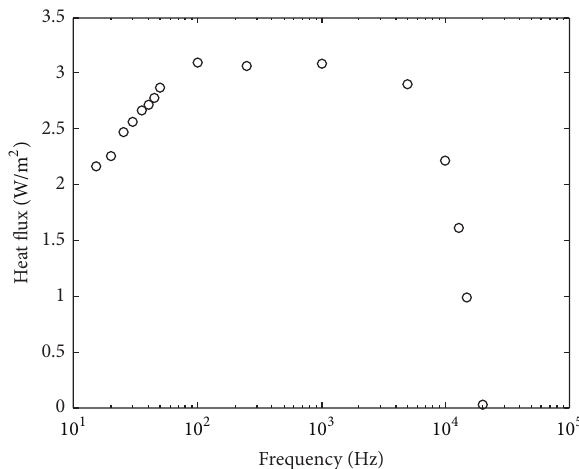
Figure1:Variationofsteadystateheatfluxatdifferentfrequenciesof excitation while RMS base velocity is kept constant at V 𝑏 = 0.54 m/s.